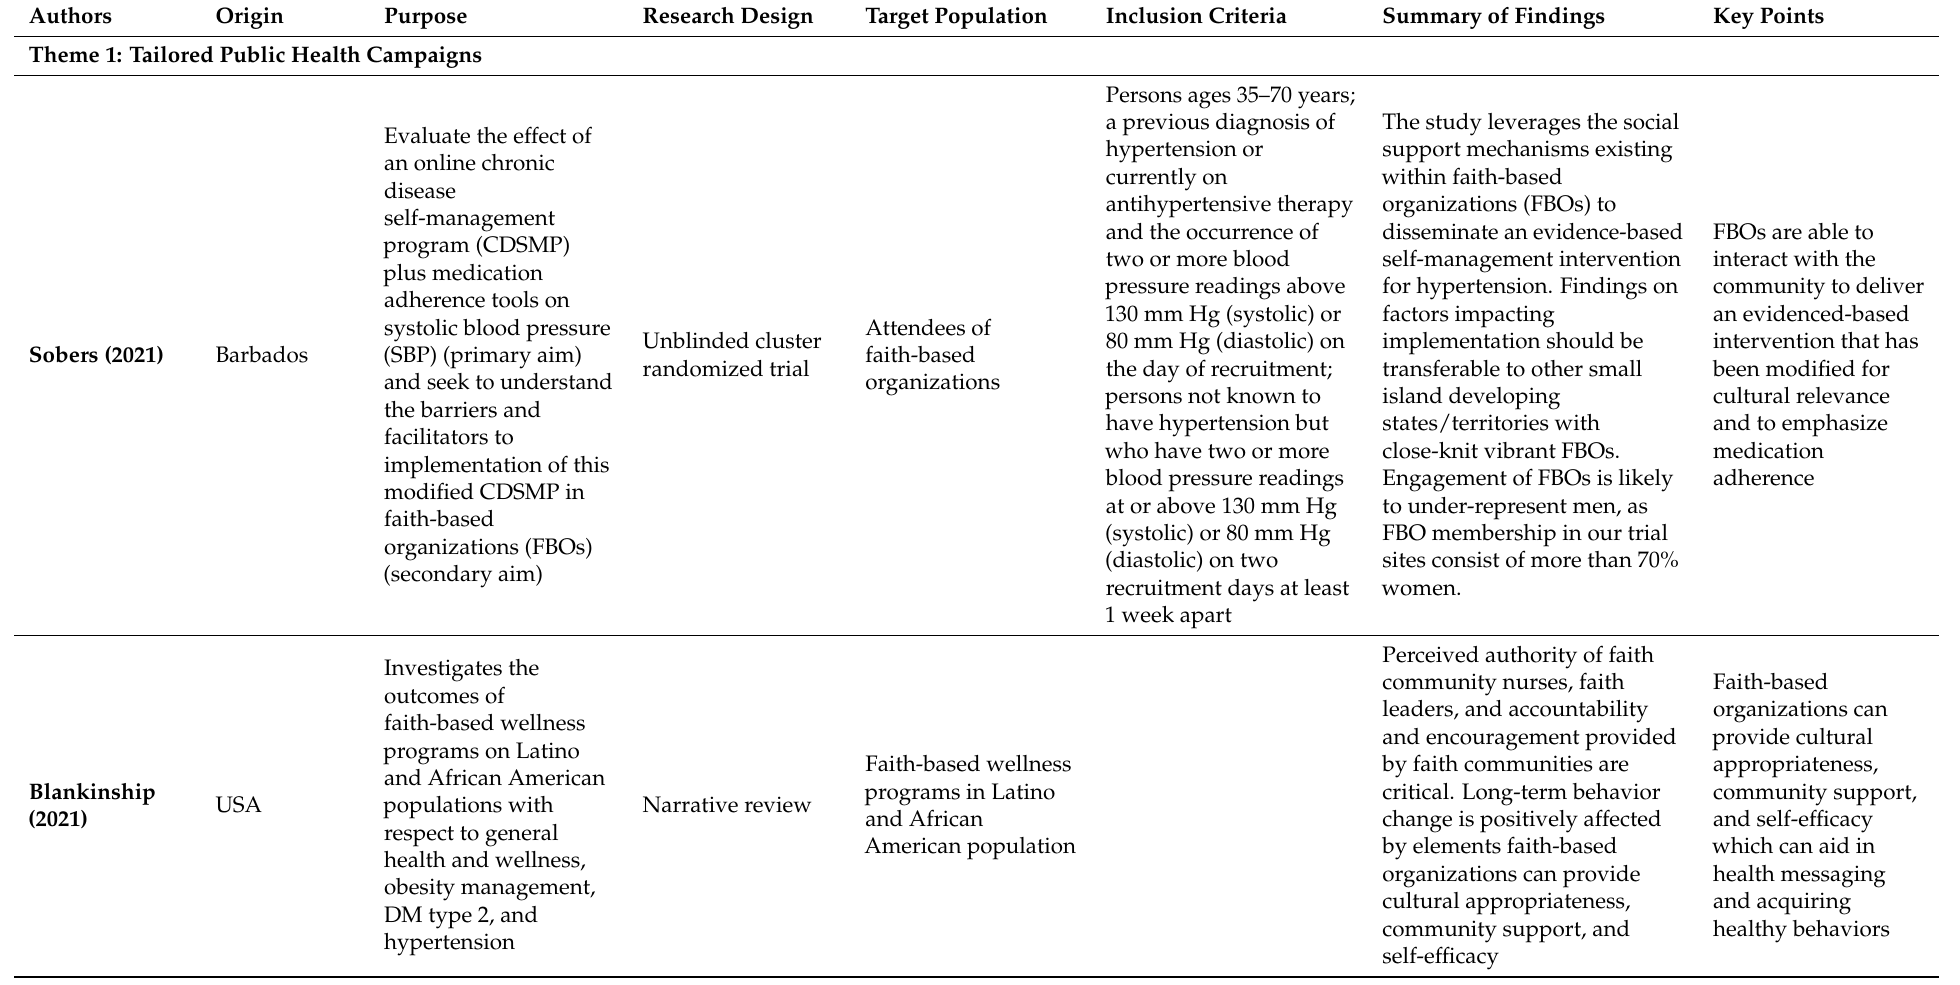
Table 1. Summary of Published Studies Focused on the Role of Faith Based Organizations in Public Health Campaigns and